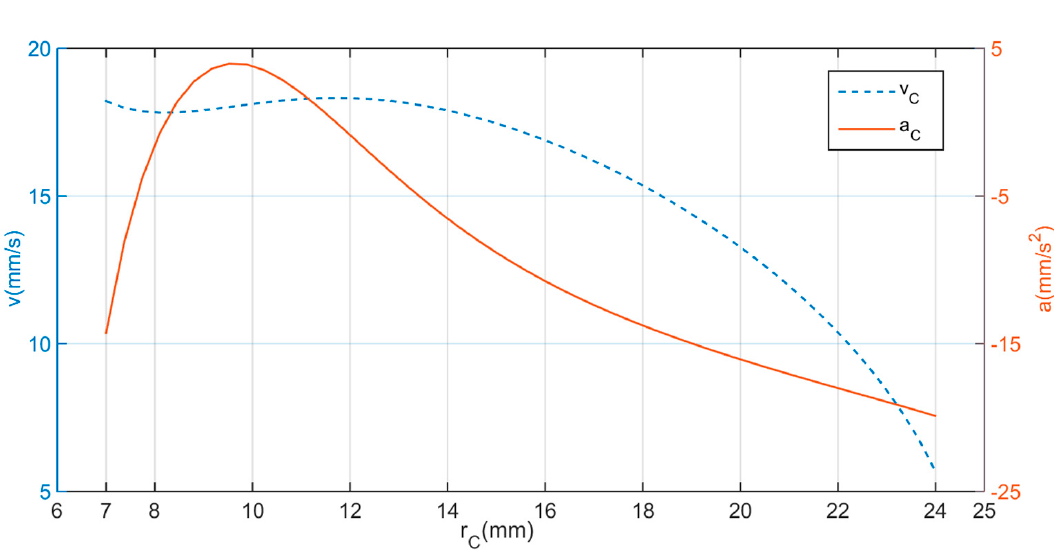
Figure 8. The velocity and acceleration curves with respect to the expanding radius of joint